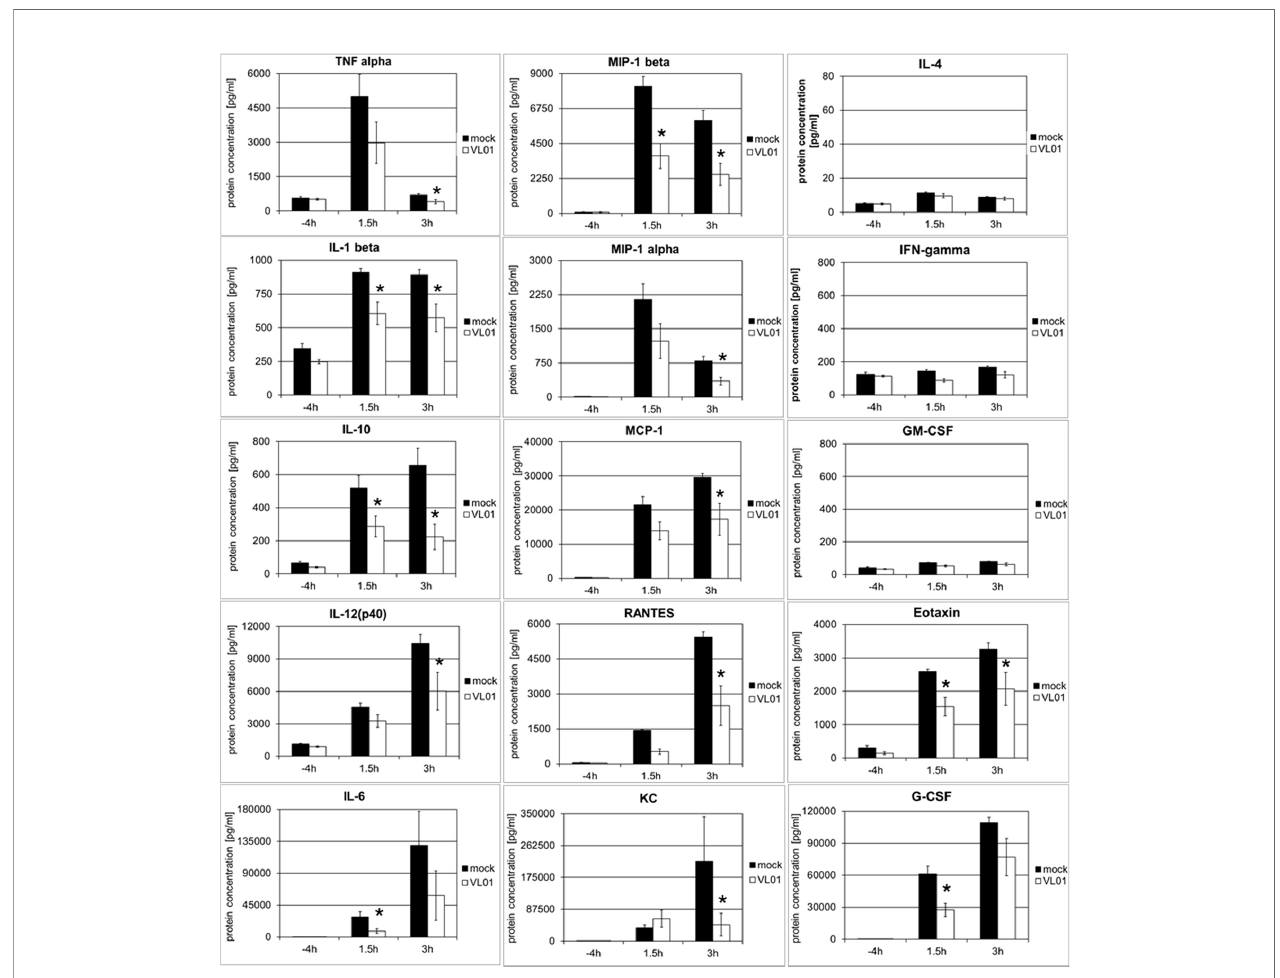
FIGURE 4 | Inhibition of LPS-induced cytokine release in BALB/c mice by the proteasome inhibitor VL-01. Balb/c mice (n = 7) were injected i.v. with VL-01 (25 mg/ kg, in 200 µl i.v.) 2 h prior LPS stimulation (20 µg/mouse, 200 ml i.p.). Cytokine levels were determined for the time points before ( − 4 h), and 1.5 or 3 h after LPS injection, using the Bio-Plex Pro Mouse Cytokine 23-Plex Panel (Biorad). *p <